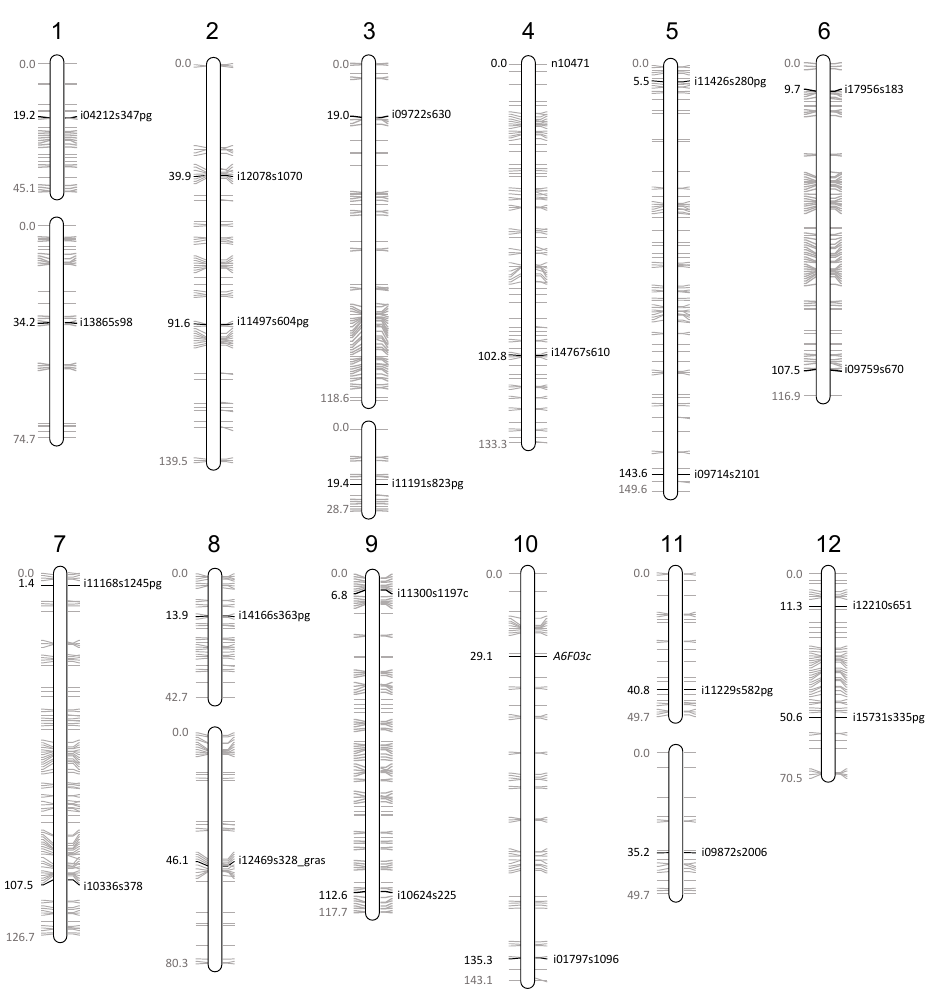
Figure 2. Location of the molecular markers on the Oria 6 genetic map. The position of the markers used to confirm the presence of all chromosome arms, as well as the size of each linkage group is indicated in centimorgans according to [28].